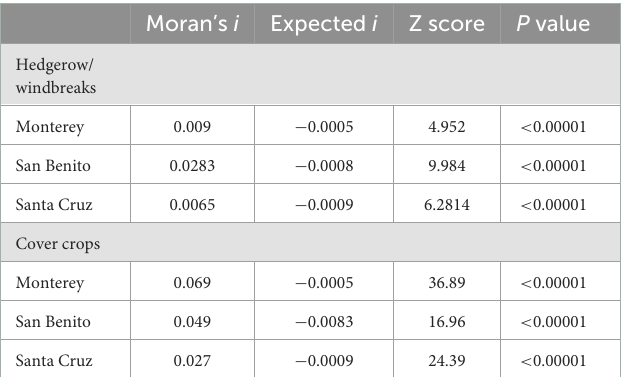
TABLE 1 Moran’s i spatial autocorrelation assessment; significant values indicate spatial autocorrelation of the practice within each county. Moran’s